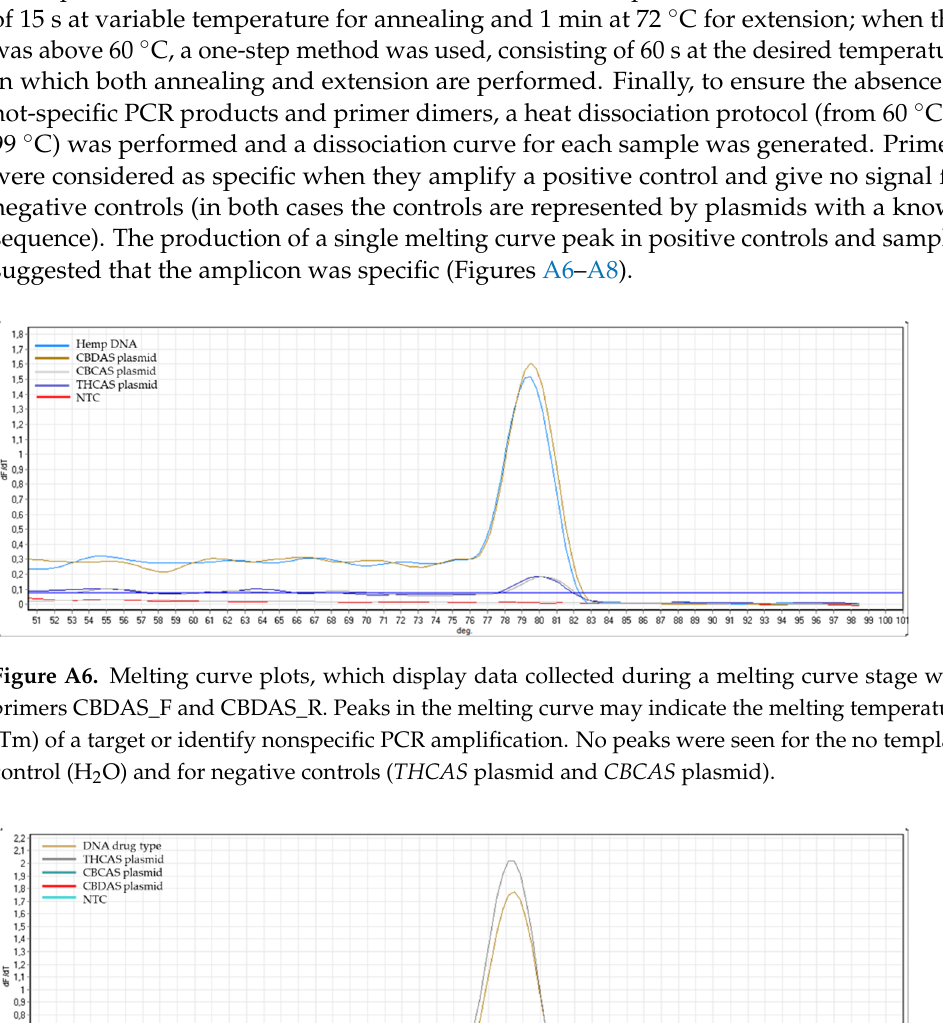
Figure A7. Melting curve plots, which display data collected during a melting curve stage with primers THCAS_F and THCAS_R. Peaks in the melting curve may indicate the melting temperature (Tm) of a target or identify nonspecific PCR amplification. No peaks were observed for the no template control (H 2 O) and for negative controls ( CBDAS plasmid and CBCAS